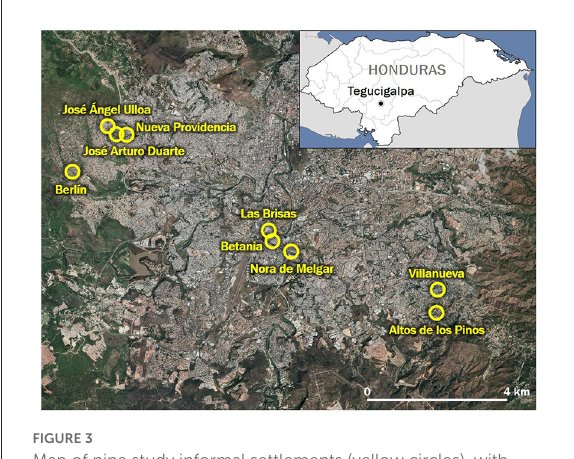
FIGURE3 Map of nine study informal settlements (yellow circles), with background satellite image of Tegucigalpa, Honduras. Credit: